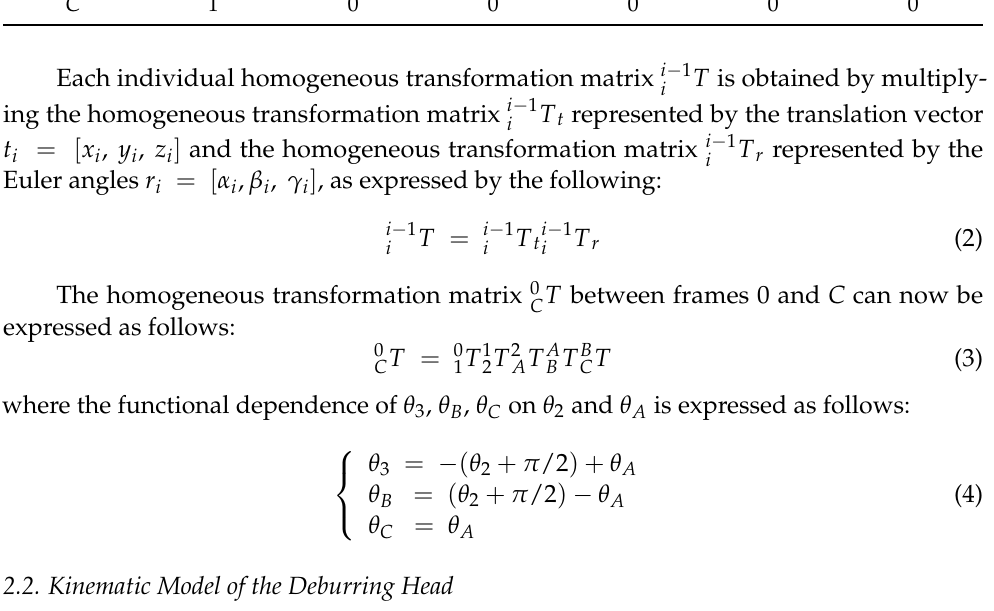
Table 2. HTM-kinematic parameters. Link i